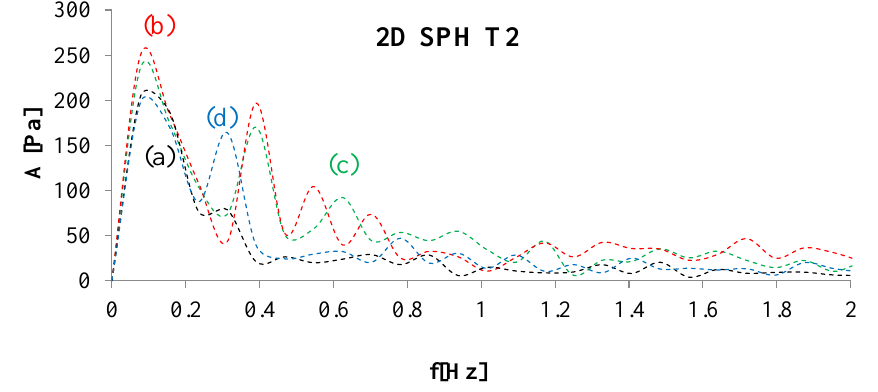
Figure 19. Amplitude spectrum of pressure fluctuations under hydraulic jump (configuration: T2) at a distance of: ( a ) 7 cm; ( b ) 10 cm; ( c ) 20 cm; and ( d ) 100 cm, from the time-averaged position of the hydraulic jump toe.